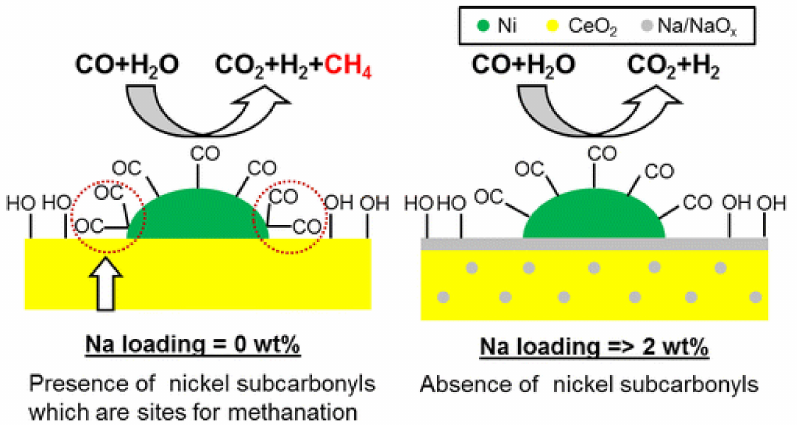
Figure 13. Mechanism of improvement of CO 2 selectivity over Ni-based catalysts [155]. Copyright 2014, ACS